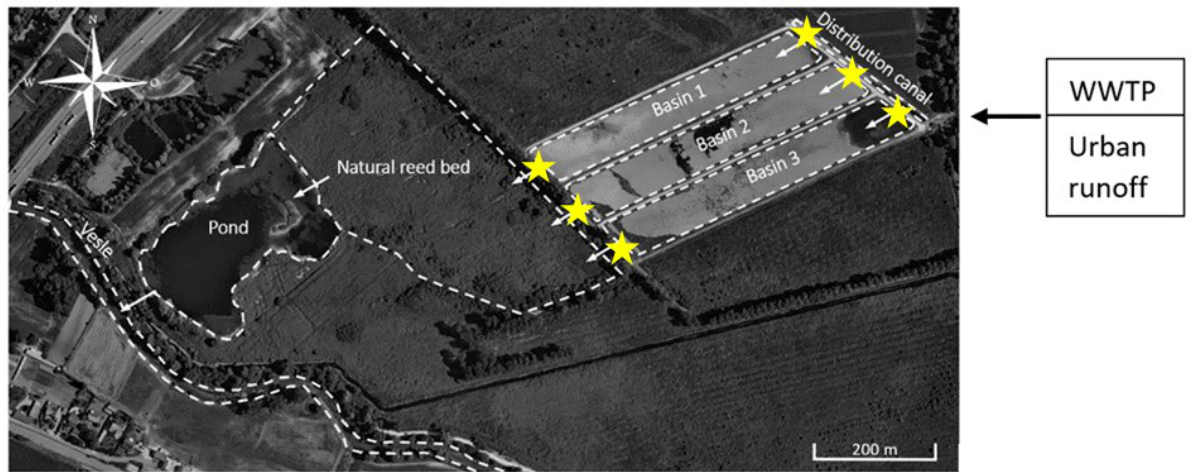
Figure 1. The surface flow constructed wetland. Modified from Google Earth (Google Inc., 2017), (image date: 28 June 2018). The stars correspond to the sampling points.